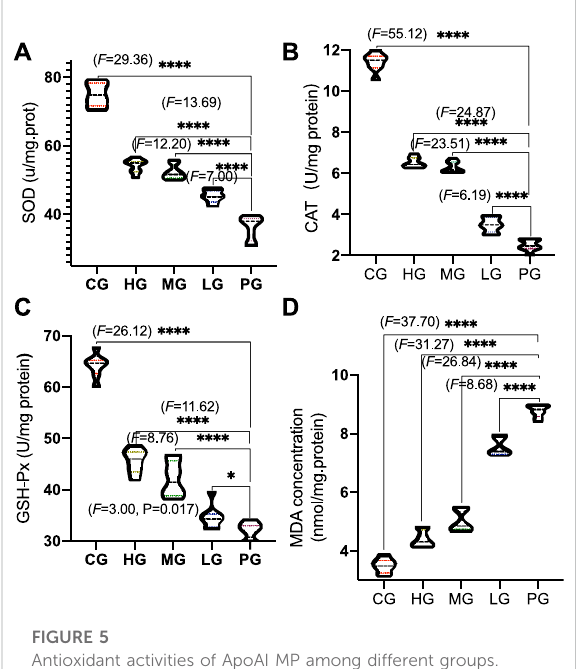
FIGURE 5 Antioxidant activities of ApoAI MP among different groups. (A) , SOD. (B) , CAT. (C) , GSH-Px. (D) , MDA. n = 8 for in each group. * p < 0.05, and **** p < 0.0001 vs. the PG group.